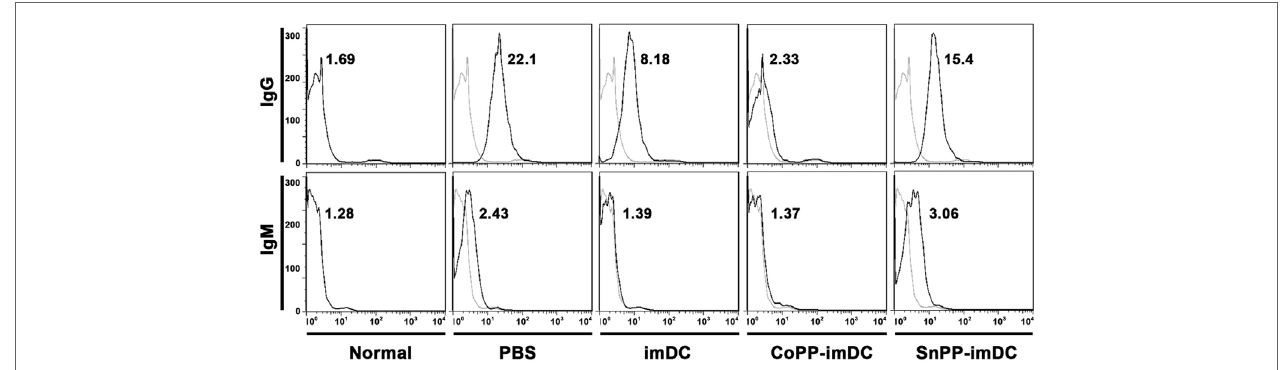
FigUre 8 | Donor-derived HO-1 hi immature dendritic cells (imDCs) are more potent in attenuating anti-donor humoral responses in cardiac allograft recipients. Untreated, cobalt protoporphyrin-pretreated, or SnPP-pretreated BALB/c mouse-derived imDCs were adoptively transferred to C57BL/6 recipients 7 days before cardiac transplantation. As a control, recipient mice received no cell transfusion, and only injection with the same volume of PBS. The sera were collected from normal C57BL/6 mice or recipient mice on day 7 after heart transplantation ( n = 3 per group). The circulating anti-donor IgG and IgM levels were detected by flow cytometry using BALB/c splenocytes as target cells. Data expressed are the Gmean values. Representative FACS results of three independent experiments are